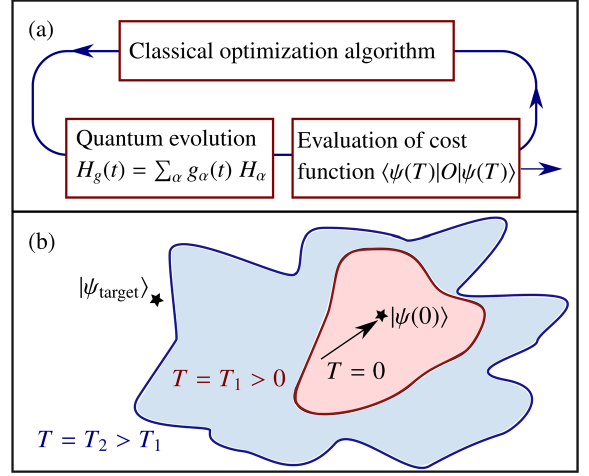
FIG. 1. (a) Variational quantum algorithm as a closed-loop learning control problem. (b) Increasing the total time expands the set of final states that one can reach with the variational protocols. The optimal protocol for a given time generates the closest state to a low energy target state within this reachable